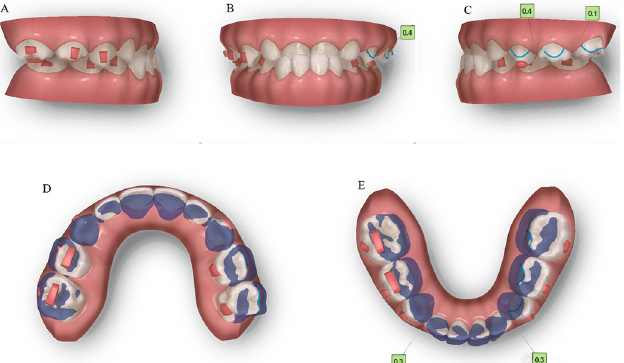
Figure 9. Pre-treatment ClinCheck ® models and ClinCheck ® treatment plan. ( A ): Lateral view of the right side of the pre-treatment model; ( B ): frontal view of pre-treatment model; ( C ): lateral view of the left side of the pre-treatment model; ( D ): occlusal view of superimposition of pre-treatment (blue) and post-treatment (white) maxillary arch models; ( E ): occlusal view of superimposition of pre-treatment (blue) and post-treatment (white) mandibular arch models.